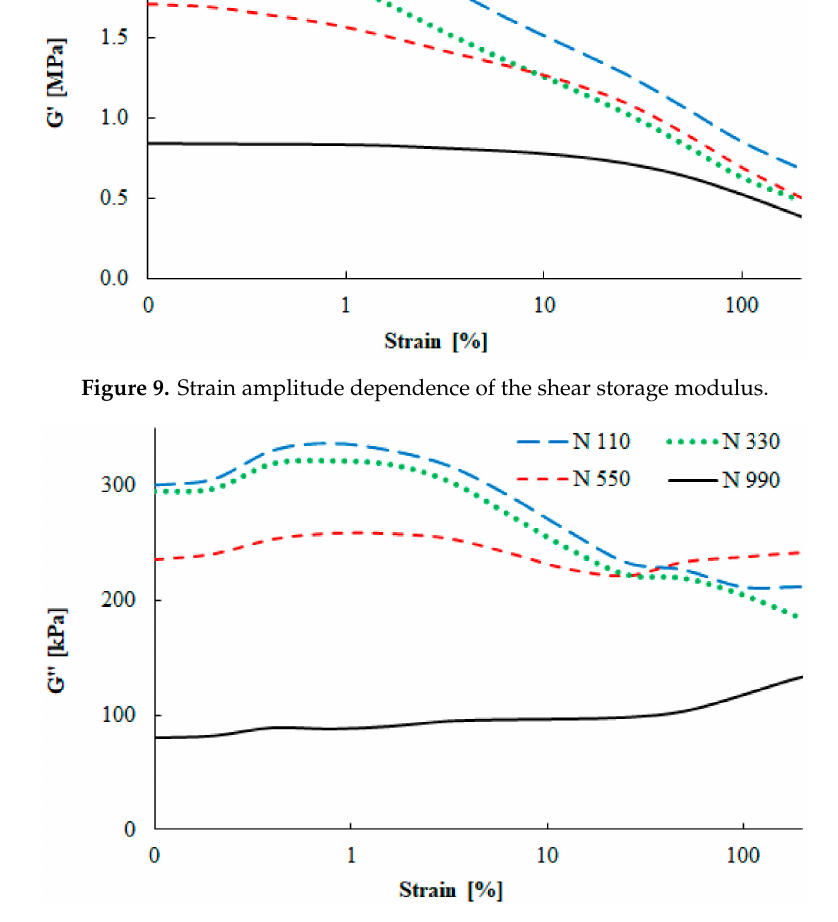
Figure 10. Strain amplitude dependence of the shear loss